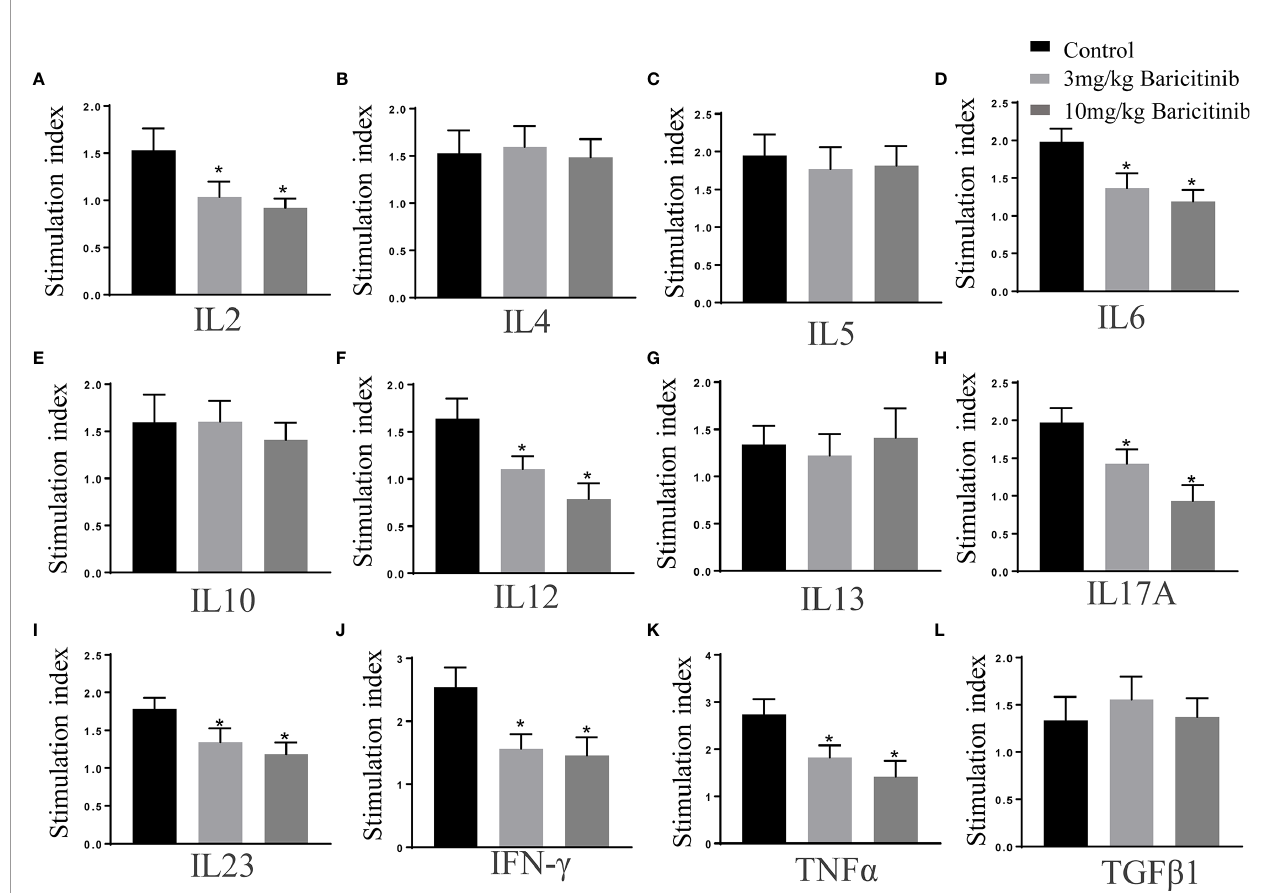
FIGURE 7 | Baricitinib treatment alters the cytokine pro fi les. Splenic mononuclear cells (MNCs) were isolated on the peak day. Cytokine pro fi les of supernatants cultured with MOG 35-55 peptide (10 m g/mL) for 72 h were investigated with ELISA kits. (A – L) The levels of IL-2, IL-6, IL-12, IL-17, IL-23, IFN- g , and TNF- a signi fi cantly reduced in the baricitinib treatment groups compared with those in the vehicle group. However, levels of IL-4, IL-5, IL-10, TGF b , and IL-13 were not signi fi cantly different. Quantitative data are the mean ± SEM. * p < 0.05; n = 6 per group. SEM, standard error of the